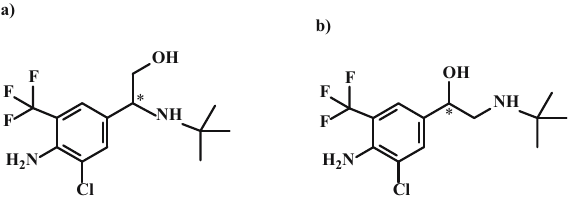
Figure 13: Chemical structure